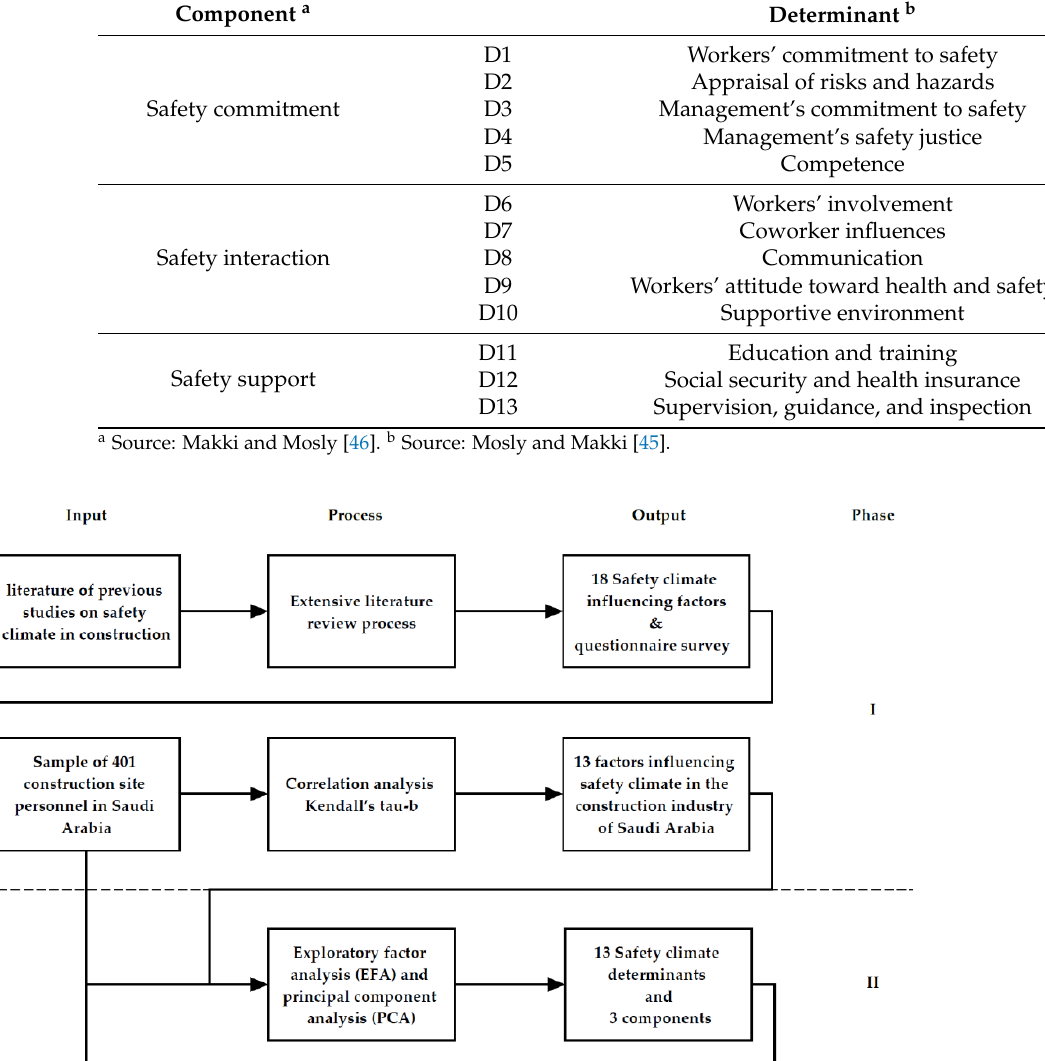
Table 1. Components and determinants of the safety climate in construction sites of Saudi Arabia.